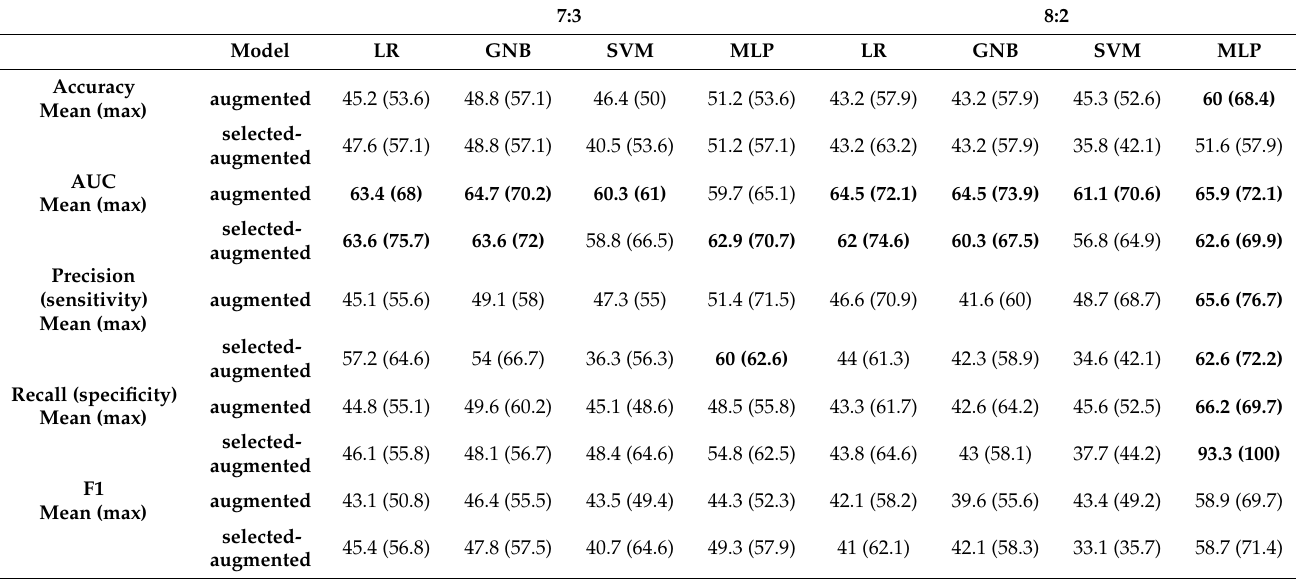
Table 4. Machine learning model performance through voice features.